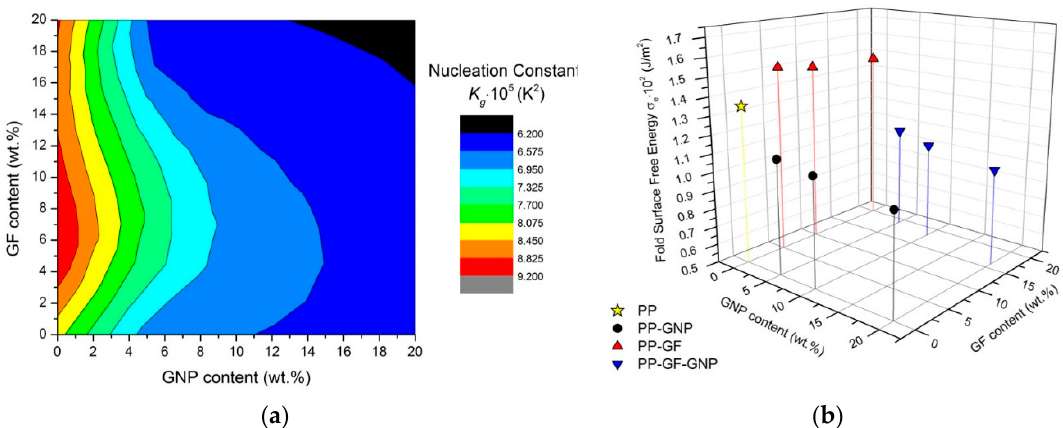
Figure 5. ( a ) Contour plot of the nucleation constant; ( b ) 3D graph of the fold surface free energy for PP and the composites.